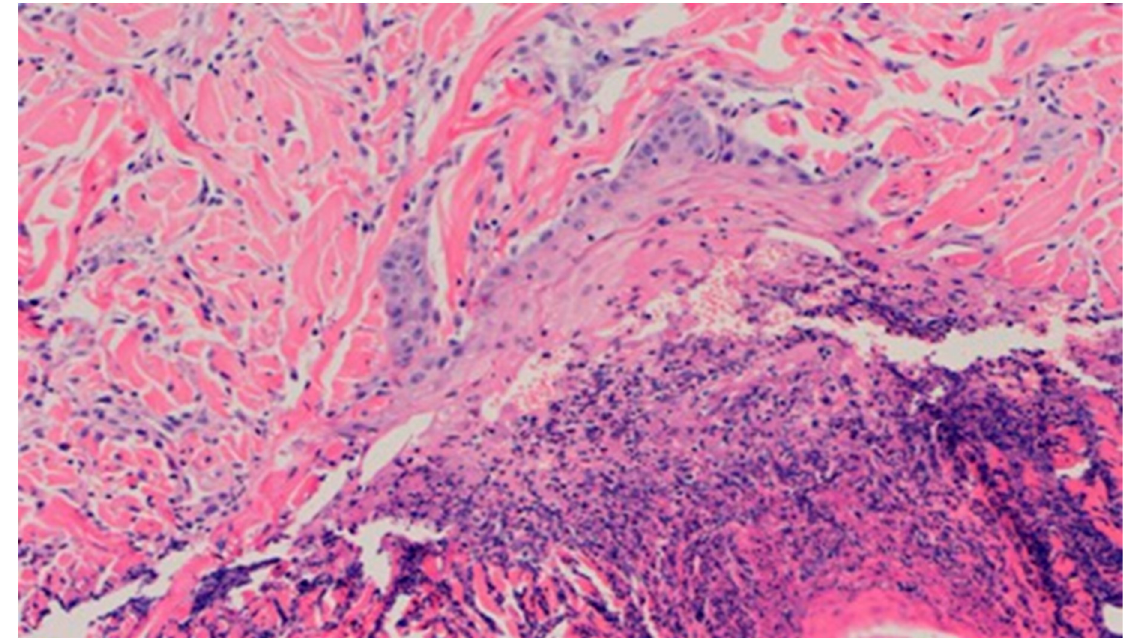
Figure 17. Focal epidermization under superficial necrosis (100×, H-E) in the wound treated with the 1% propolis ointment on day 10.